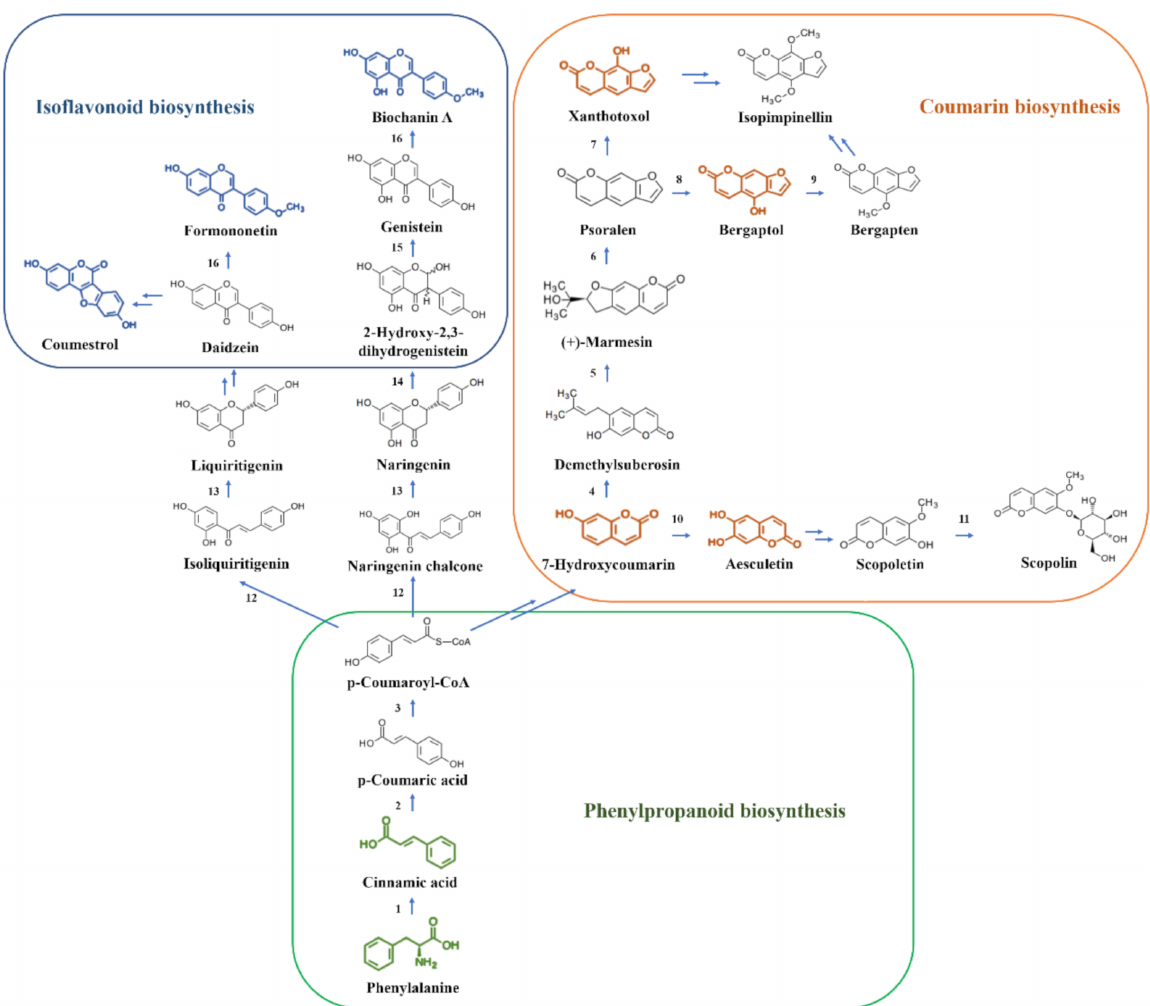
Figure 3. The flavonoid biosynthesis pathway in A.